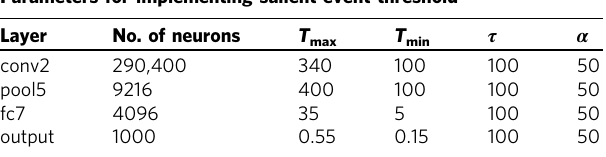
Parameters for implementing salient event